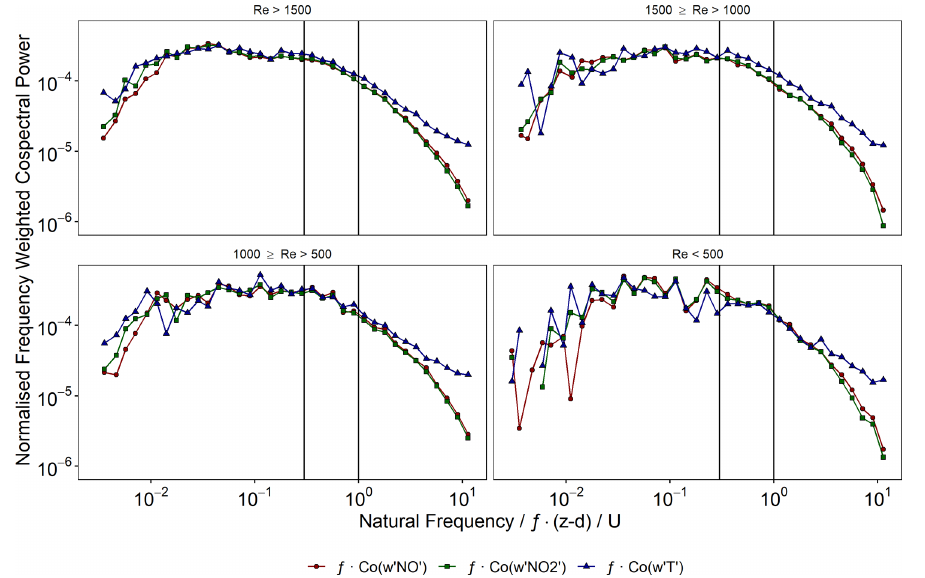
Figure 6. Normalised co-spectra of vertical wind with NO (red, circle), NO 2 (green, square), and temperature (dark blue, triangle). Co- spectra are grouped by main sample line Reynolds number. Vertical bars mark 0.3 and 1Hz; data at frequencies greater than these have been used to derive the correction factors presented in Table